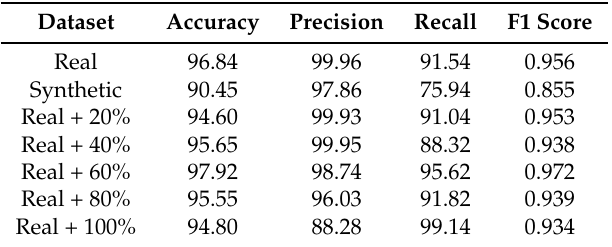
Table 1. The classification results of the classifier trained with real data, synthetic data, and real data augmented by different synthetic data